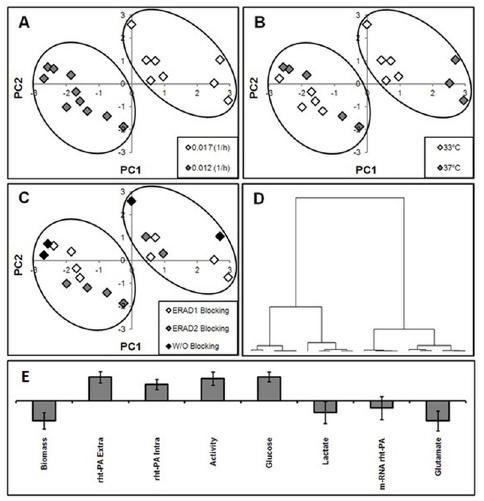
Fig 3. Principal Component Analysis (PCA). A, B and C: Hyperplane between the first and second principal components (PC1 and PC2, respectively). A, B and C show the same hyperplane, but the symbols are coloured differently in each inset to indicate the factors studied. D: Dendrogram (Ward distance) of the observation used in PCA to identify the two defined groups in A, B and C. E: Loadings of the first principal component (PC1) shown in A, B or C (bars represent C.I.